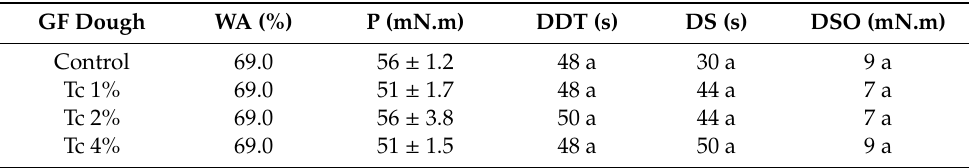
Table 2. Parameters obtained from Micro-doughLab mixture curves of Control and GF dough with T. chuii Tc 1%, Tc 2% and Tc